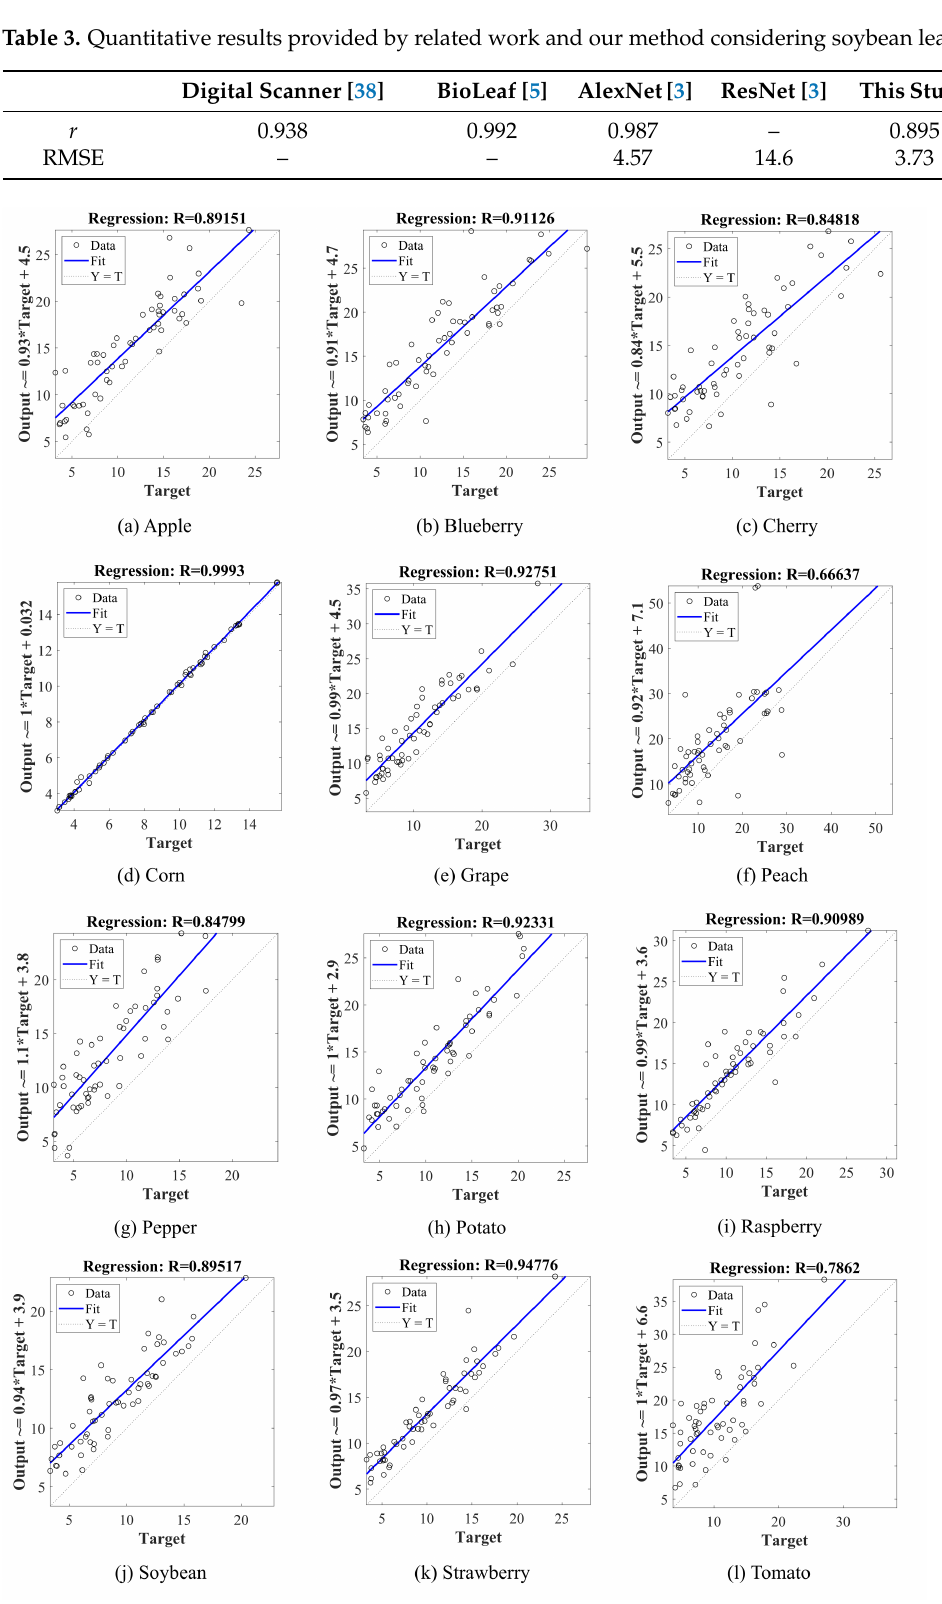
Figure 4. Regression line between ground-truth defoliation levels and estimated damage by our method concerning different plant species. Target T refers to the reference data, while Y refers to the estimated